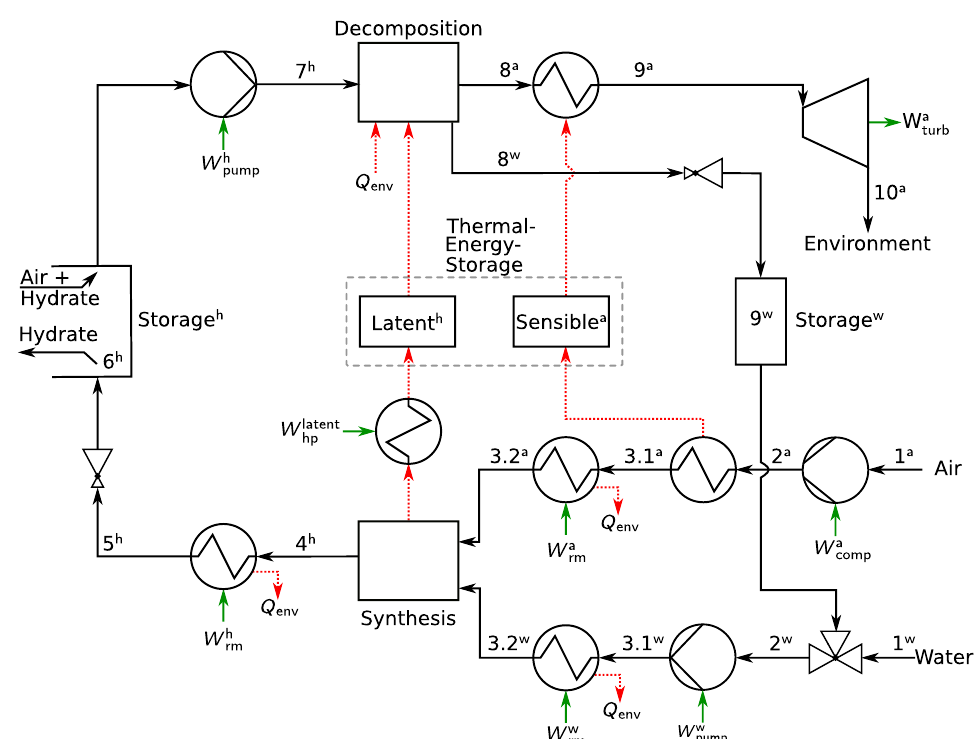
Figure 2. Simplified process scheme of a reference plant for SAES. Solid black lines denote pathways for media transport. Dashed red lines are used to indicate heat transport. Short green arrows are used to label energy flows. In the state labeling, consecutive numbers are used according to a “energy charging → energy storage → energy discharging” order. Superscripts “a”, “w”, and “h” denote air, water and hydrate (i.e., SA),